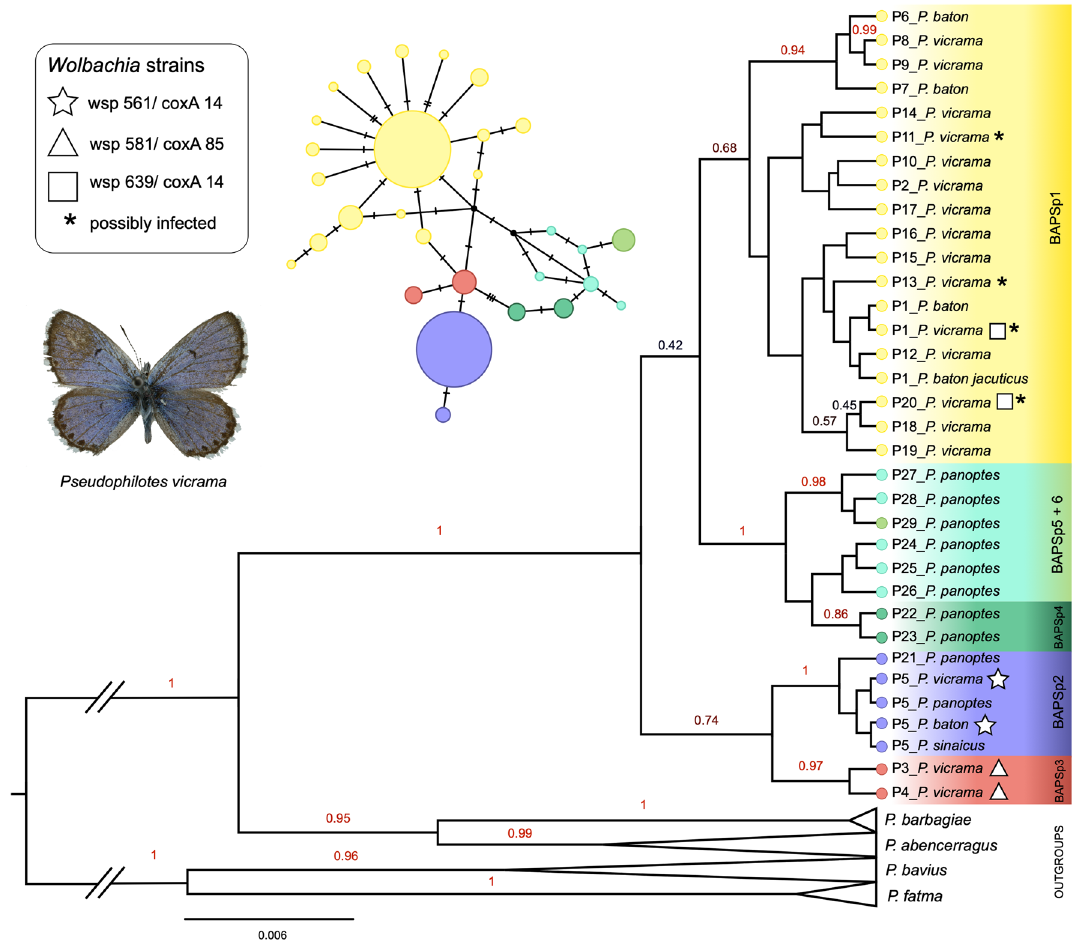
Figure 4. Mitochondrial Bayesian phylogenetic tree of Pseudophilotes spp. COI haplotypes. The branch labels represent posterior probabilities > 0.4. Haplotypes positive for Wolbachia are marked. The tree was visualized in FigTree v. 1.3.1 (https ://githu b.com/ramba ut/figtr ee). Graphics was compiled in Graphic for Mac v. 3.1 (https :// www.graph